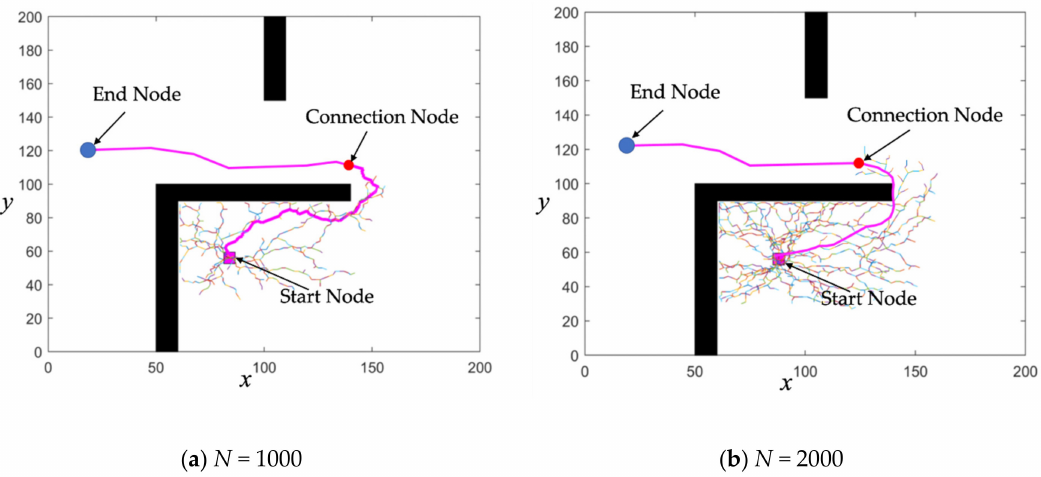
Figure 17. Assembly paths planned with different N of Case Study